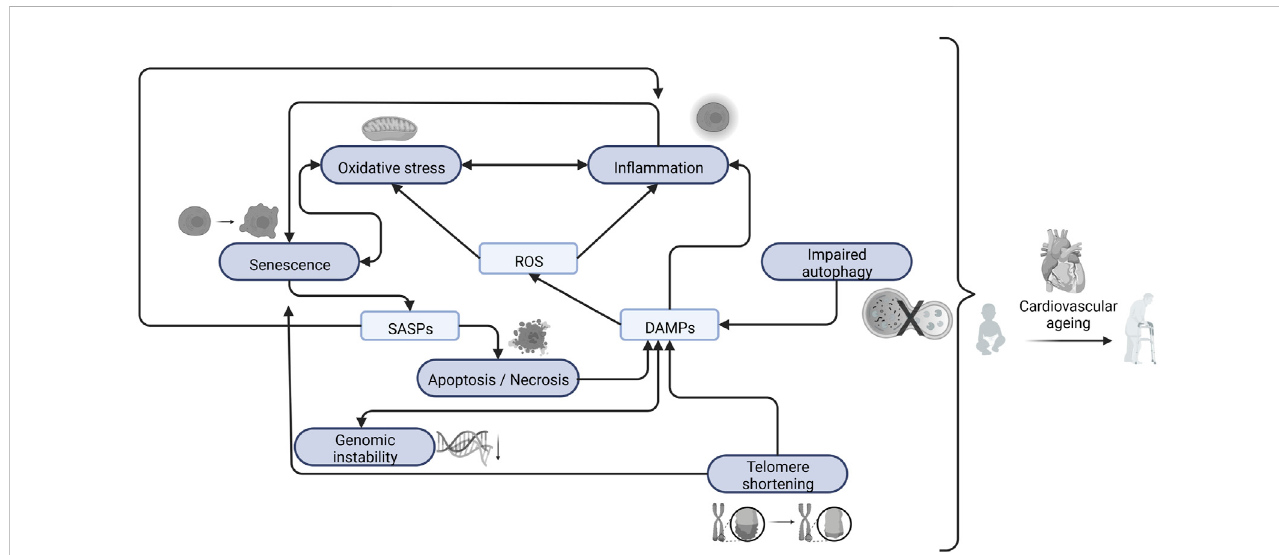
FIGURE 2 Interaction between the main cellular and molecular changes that causes cardiovascular ageing. Created with BioRender. Abbreviations: ROS, Reactive Oxygen Species; SASPs, Senescence Associated Secretory Phenotype; DAMPs, Damage-Associated Molecular